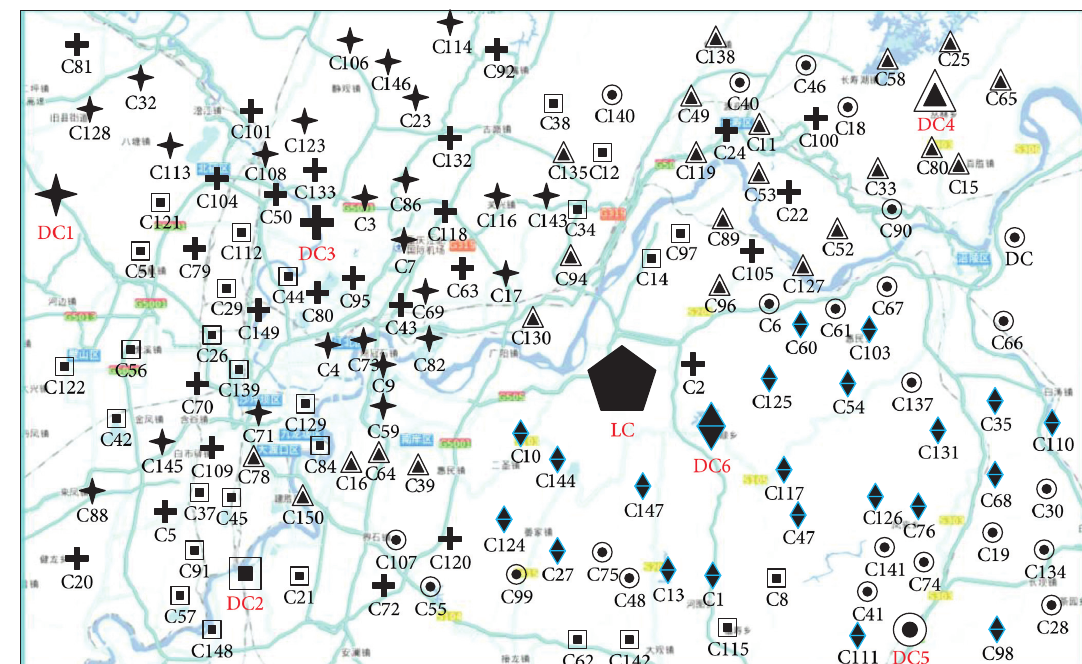
Figure 5: Spatial distribution of logistics facilities and